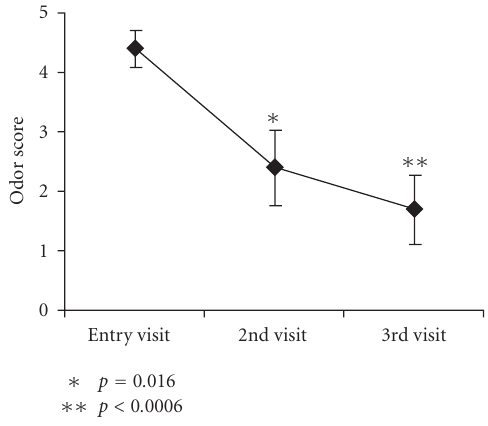
Figure 1: Perceived vaginal odor scored from the visual analog scale by subjects shows significant reduction ( (cid:0) P = . 016) on 2nd visit with further reduction ( (cid:0)(cid:0) P < . 0006) on 3rd visit. Data presented standard error, n = 10. as mean (cid:0)